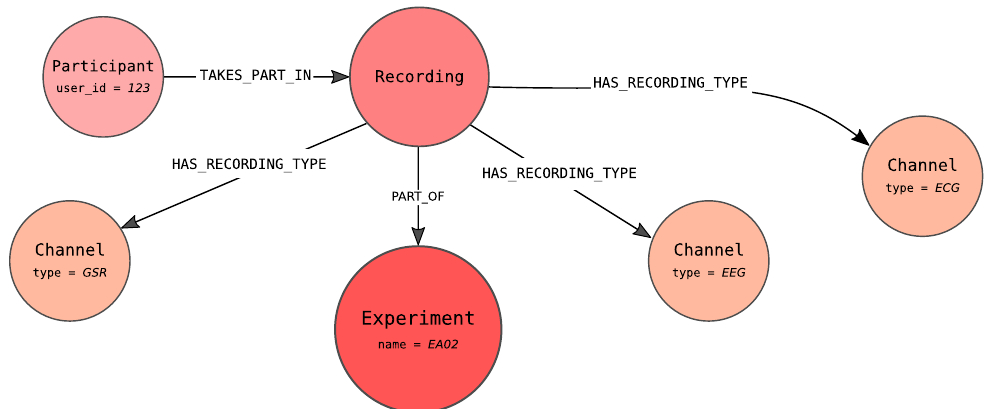
Figure 6. Contextual information for the exemplary Recording